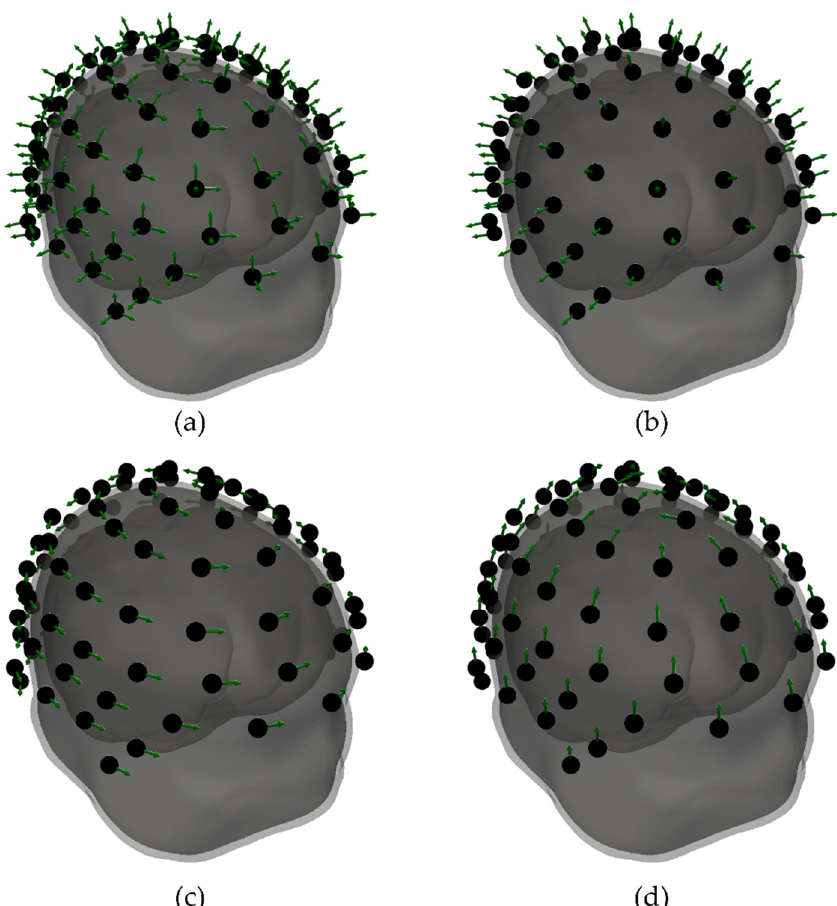
Figure 1. Different configurations of OPM-MEG for one selected subject: ( b ) normal components (OPM-NOR), ( c ) tangential components along lines of latitude (OPM-TAN-LAT), ( d ) longitude (OPM-TAN-LON) and ( a ) all three components combined (OPM-ALL). The gray surfaces show individual BEM mesh model layers. The center of the black dots represents the center of the OPM sensors, and the green arrows show the sensors’ sensing directions. The sensor count for this subject is 93.